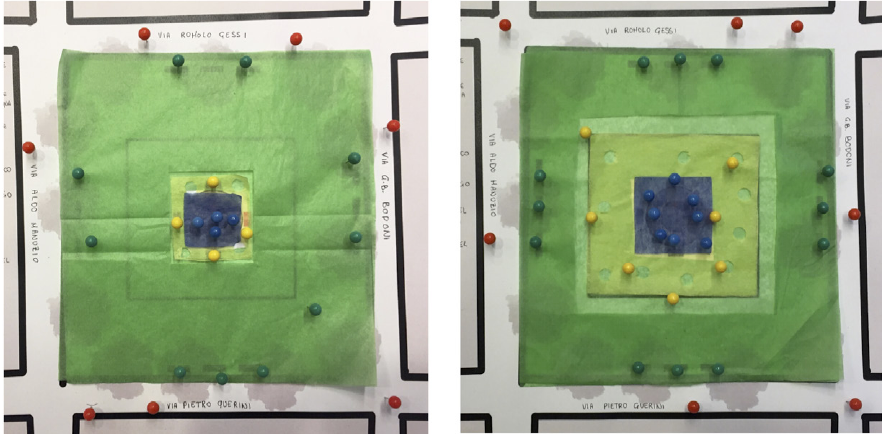
Figure 2: Visualization of sound perception in Piazza Testaccio, morning, 11.30 a.m. Colors Legend as in Figure 1B ( A ) blindfolded.